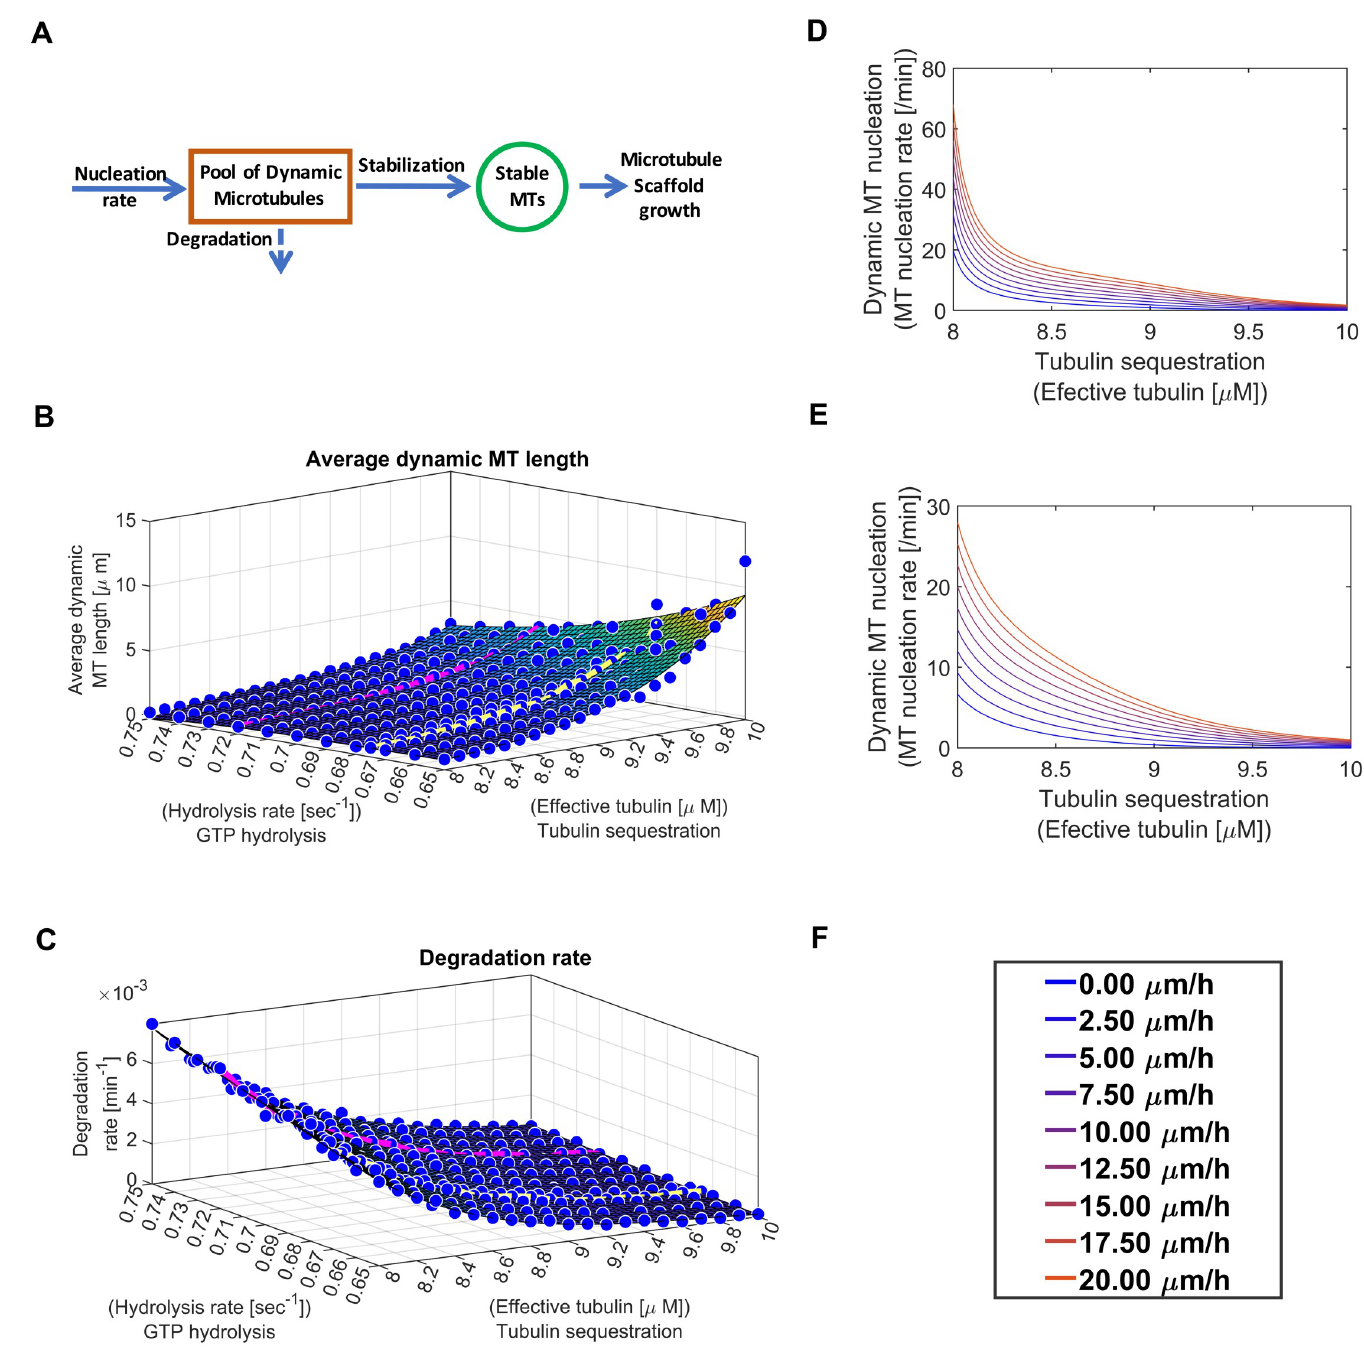
Fig 7. Redundancies among microtubule growth Level-3 sibling SCPs. (A) Summary of the basic reaction for the simulation of MT growth. (See S1 Fig) for details. (B), (C), (D) & (E) Level-3 SCPs that define sub-functions of the Level-2 SCP Dynamic MT growth show complementary activities to allow NOG without violation of the model constraints. Multiple combinations of the SCP activities Tubulin Sequestration , GTP Hydrolysis and Nucleation of Dynamic MTs enable NOG with a given velocity. (B-C) The influence of the SCPs Tubulin Sequestration (which determines the effective tubulin concentration) and GTP Hydrolysis on the length distribution (B) and degradation rate (C) of the dynamic MTs were determined in a pre-simulation using a stochastic model for the simulation of single dynamic MT growth (Margolin et al). Colored lines refer to the selected GTP hydrolysis rates shown in (B) and (C) (pink: 0.72/sec, d) and (yellow: 0.675/sec, e). (D-E) Multiple combinations of dynamic MT nucleation rates and effective tubulin concentrations allow NOG under a given velocity for each GTP hydrolysis rate, as shown for the hydrolysis rate of 0.72/sec (d) and 0.675/sec (e). (F) Velocities in (D) and (E) were color coded as indicated.